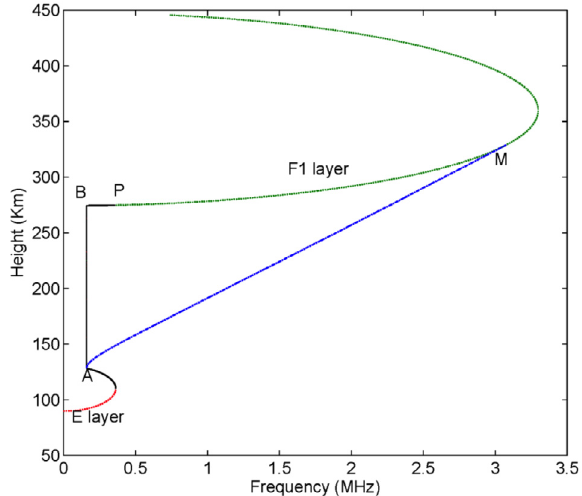
Figure 2. MQP-VD ionosphere